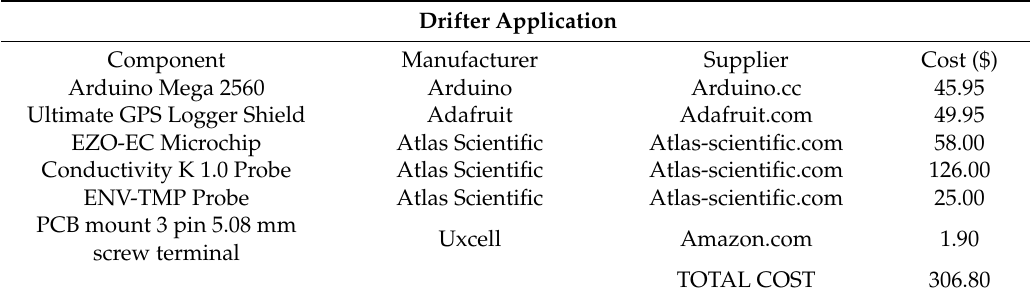
Table 1. Individual and total component costs for the drifter and moored sonde